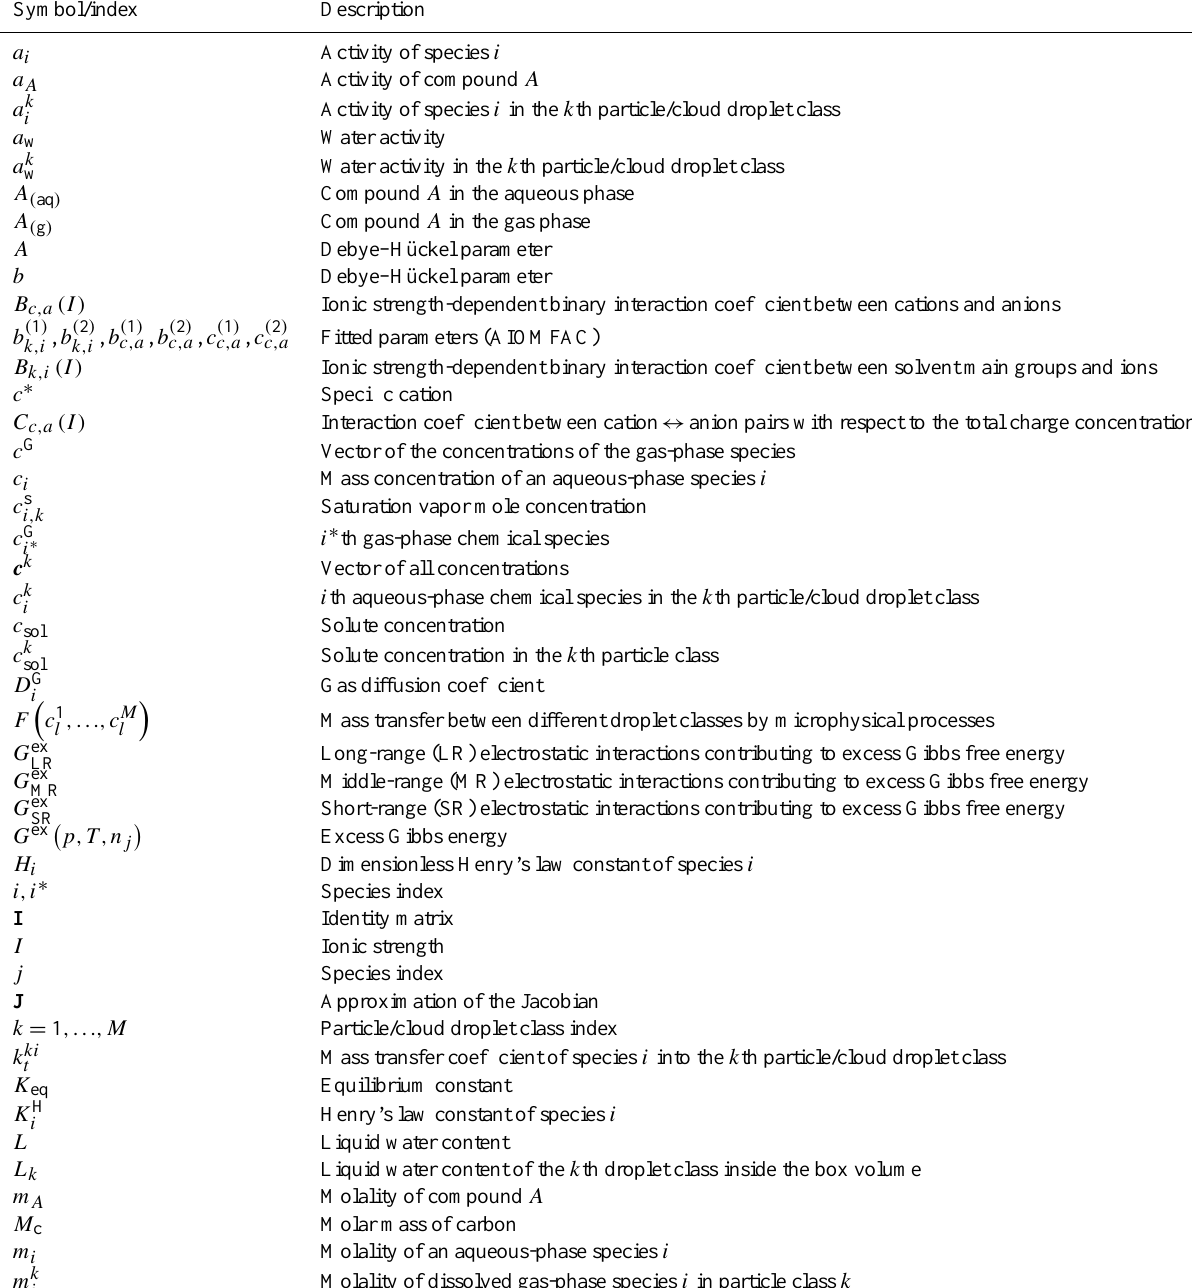
Table B1. List and description of symbols and